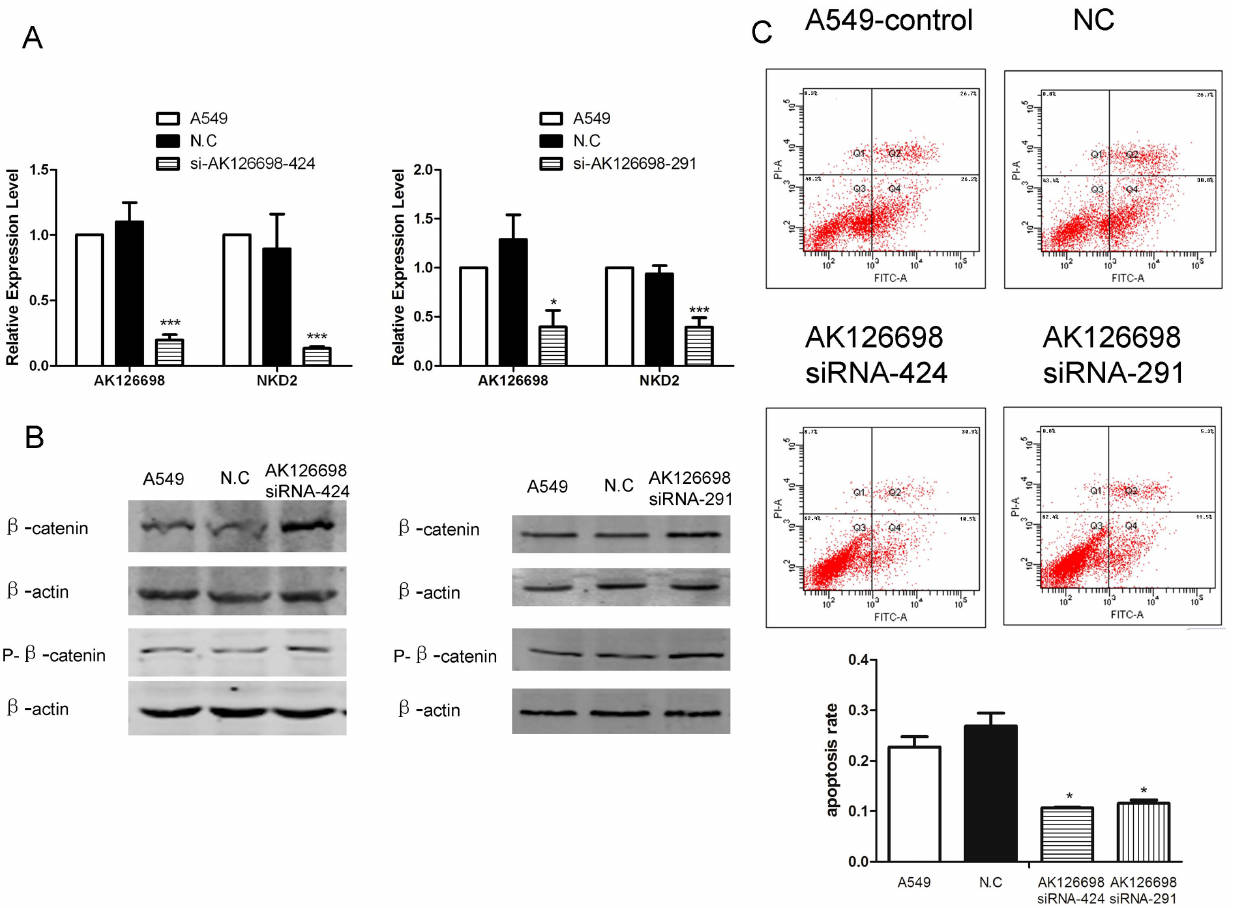
Figure 5. Effects of AK126698 on Wnt pathway and cell apoptosis. Silencing of AK126698 by siRNA in A549 cells and altered NKD2 mRNA expression in AK126698 knockdown A549 cells (A). Western blot analysis of b -catenin and phospho- b -catenin levels in AK126698 knockdown A549 cells (B). Apoptosis evaluated by flow cytometry in AK126698 knockdown A549 cells (C). Values are means 6 SD and obtained from three independent experiments. *P , 0.05, ***P , 0.001 compared with A549 and negative control. NC: A549 treated with siRNA negative control; AK126698 siRNA-424, A549 treated with siRNA AK126698-424; AK126698 siRNA-291, A549 treated with siRNA AK126698-291; P- b -catenin, phospho- b -catenin.